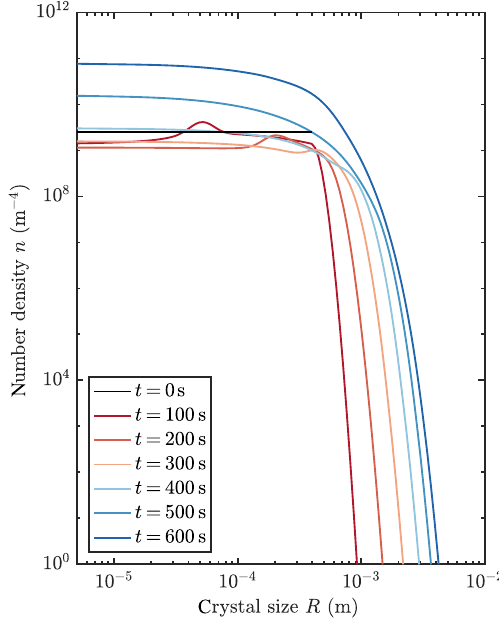
Figure 5. Evolution of crystal size distribution for initial conditions that permit a frazil explosion (red curve in Fig.